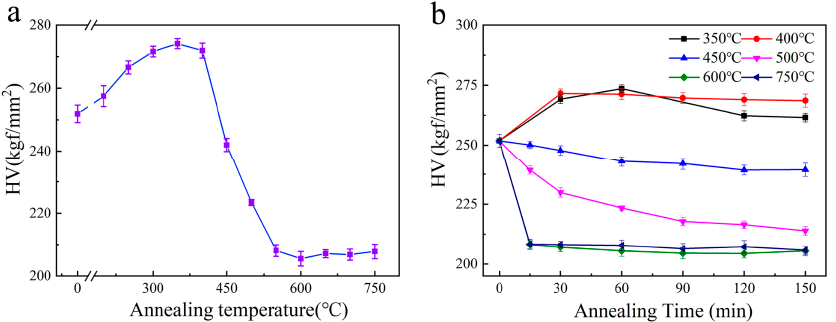
Figure 3. Microhardness development of the UFG TiFeB alloy: ( a ) isochronal annealing; ( b ) isothermal annealing.